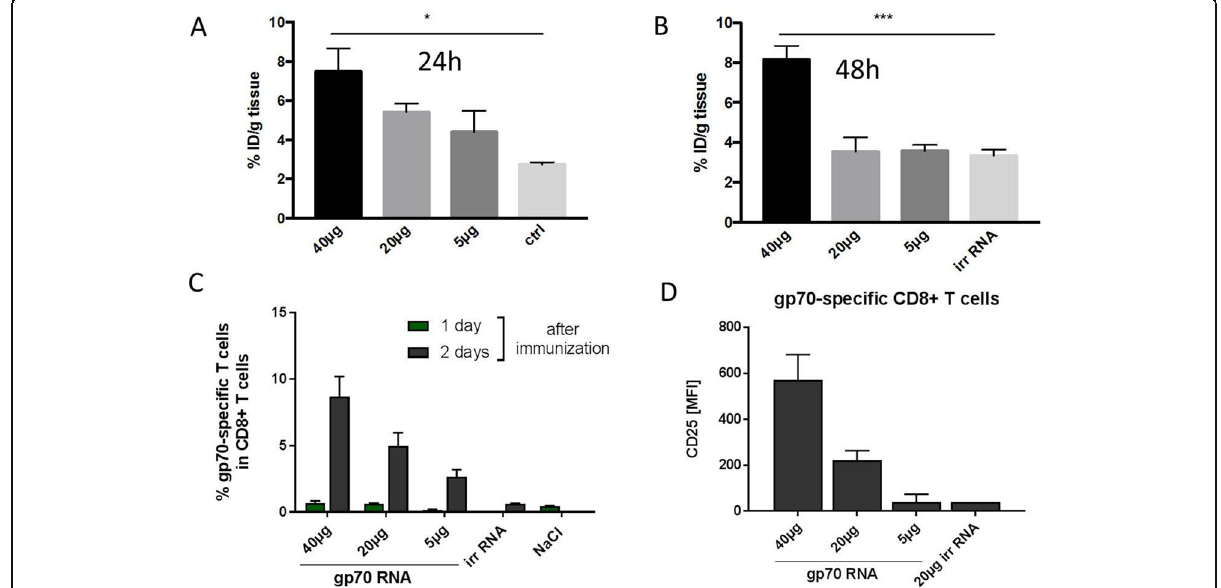
Fig. 3 Dose dependency of the immune response after 2 cycle of vaccination as measured by spleen FDG uptake and FACS analysis. Spleen FDG uptake determined by ex vivo biodistribution 24 h ( a ) and 48 h ( b ). A clear dose response is more evident after 24 h, indicating the major role of rapid activating processes. c Dose response for T cell proliferation at days 1 and 2. d Dose response of CD25 expression on gp70-specific CD8